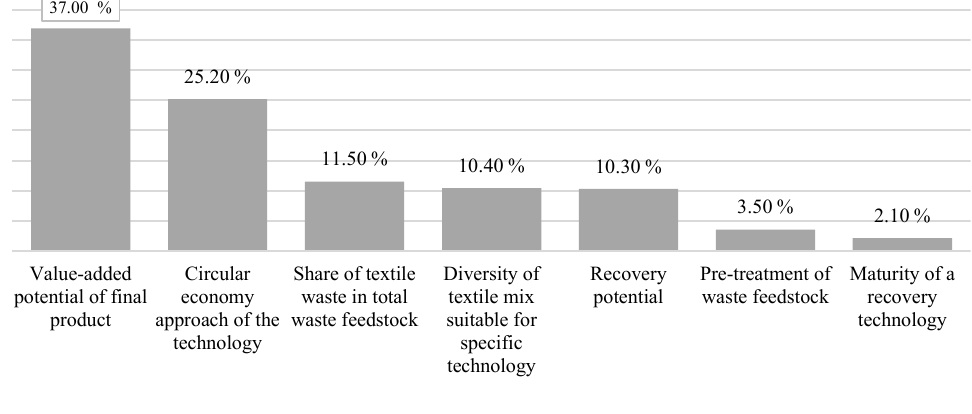
Fig. 4. Importance weighting scores for the textiles waste recovered